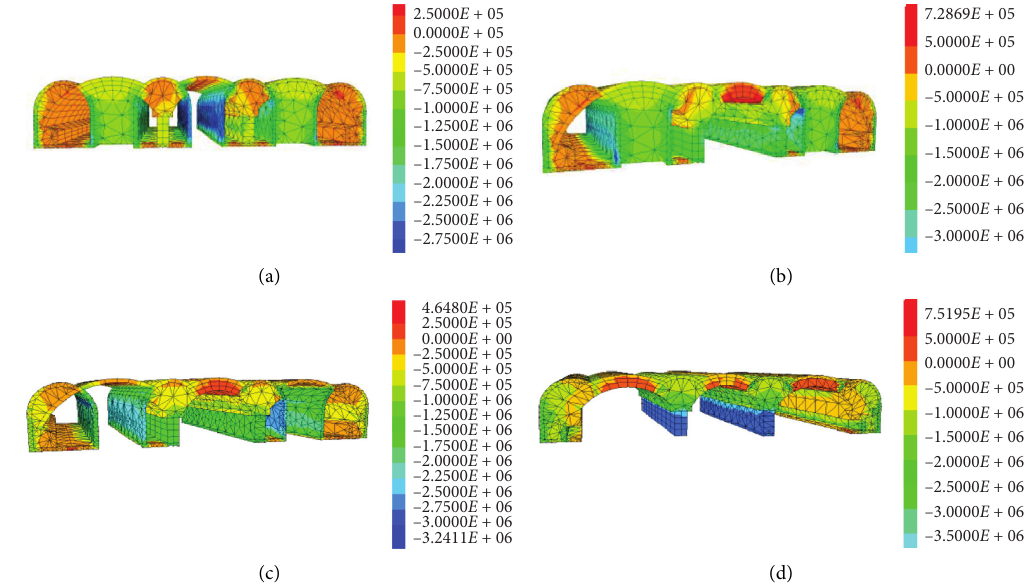
Figure 16: Principal stress of arches (pa). (a) Stage 5-1. (b) Stage 5-2. (c) Stage 5-3. (d) Stage